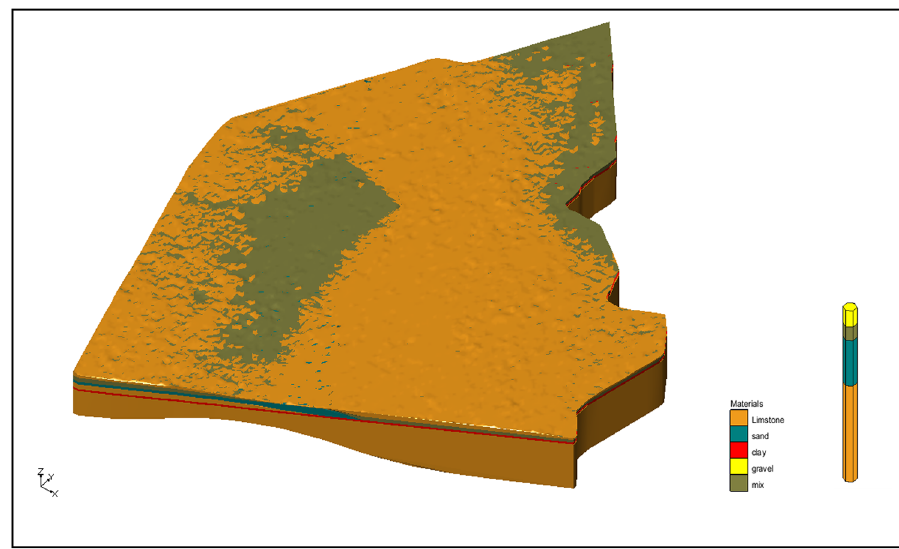
Figure 2: Geological formation and the borehole cross - section of the study